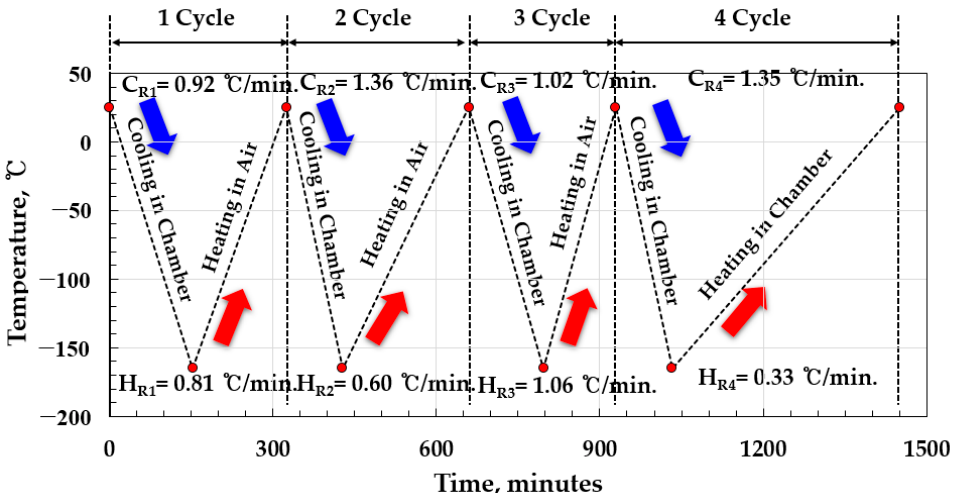
Figure 3. Heating and cooling rates in the loading and unloading conditions.